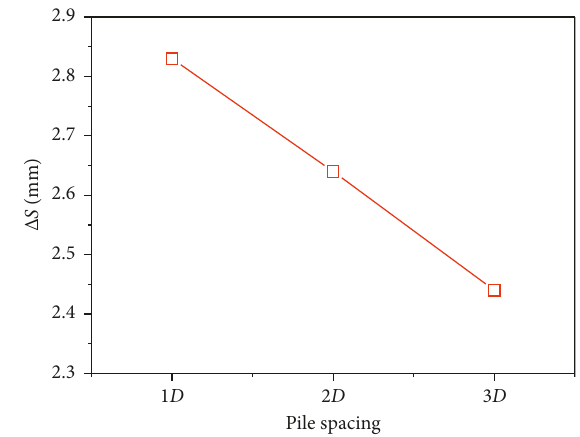
Figure 34: Decrement in maximum horizontal displacement of the tunnel structure under different isolation pile